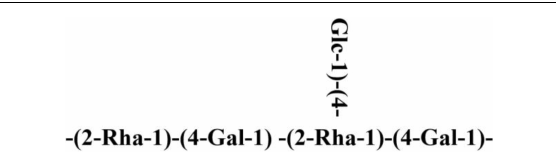
respectively. The absorption peak at 18.41 ppm was the typical methyl signal peak of rhamnose. The chemical shifts of carbon and hydrogen on K-CMLP were assigned by 1 H- 1 H COSY ( Figure 5C ) and HSQC ( Figure 5D ), and the results are summarized in Table 3 . In the HMBC spectrum ( Figure 5E ), the (Gal-H4, Rha-C1) and (Rha-H1, Gal-C4) cross-peaks indicated that the rhamnose residue was connected to O-4 of galactose. The cross-peaks (Gal-H1,